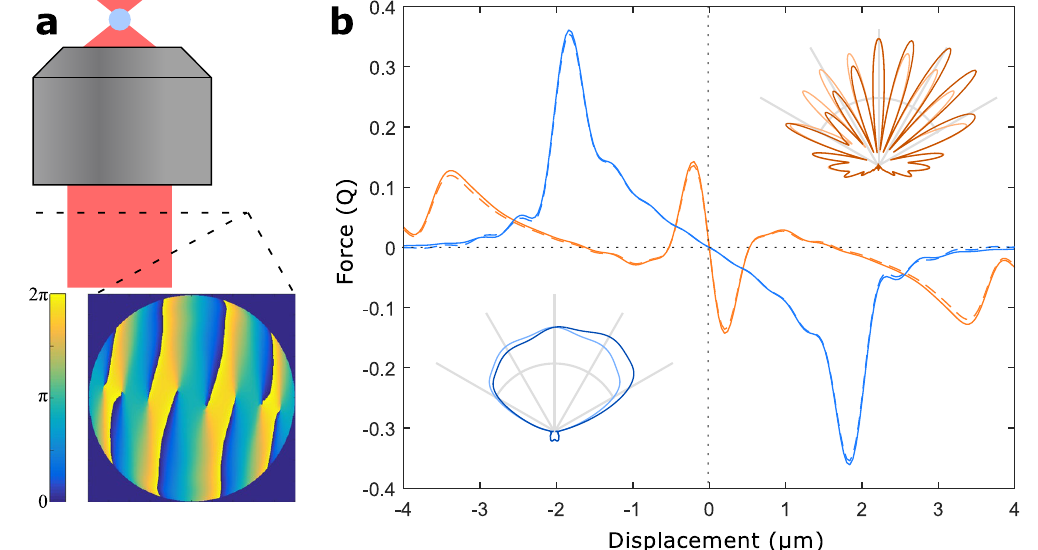
Figure 1. Enhanced trapping with phase-engineered light. ( a ) The system considered here has a phase profile applied at the back-focal plane of the trapping objective. This example is calculated for 3.5 μ m silica spheres in water with y polarized light. ( b ) The resulting force as a function of displacement, both for a diffraction-limited trap (blue) and with the calculated phase profile (orange). This is calculated both with the Optical Tweezers Toolbox 16 (solid lines) and Eq. (6) (dashed lines), with the two methods showing near-perfect agreement. In this example the phase profile increases the trap stiffness by a factor of 15.5. For the remainder of the paper we use the Optical Tweezers Toolbox for all optical force and trap stiffness calculations. Insets: polar plots of the transmitted intensity after the particle, both when the particle is centered (light) and when displaced by 50 nm (dark). The diffraction-limited trap shows a small angular deflection in response to particle movement, with minimal change in the overall shape. By contrast, the particle acts to separate the phase-optimized fields into discrete interference fringes, with particle displacement causing light to be redirected between different intensity peaks, as described in ref.